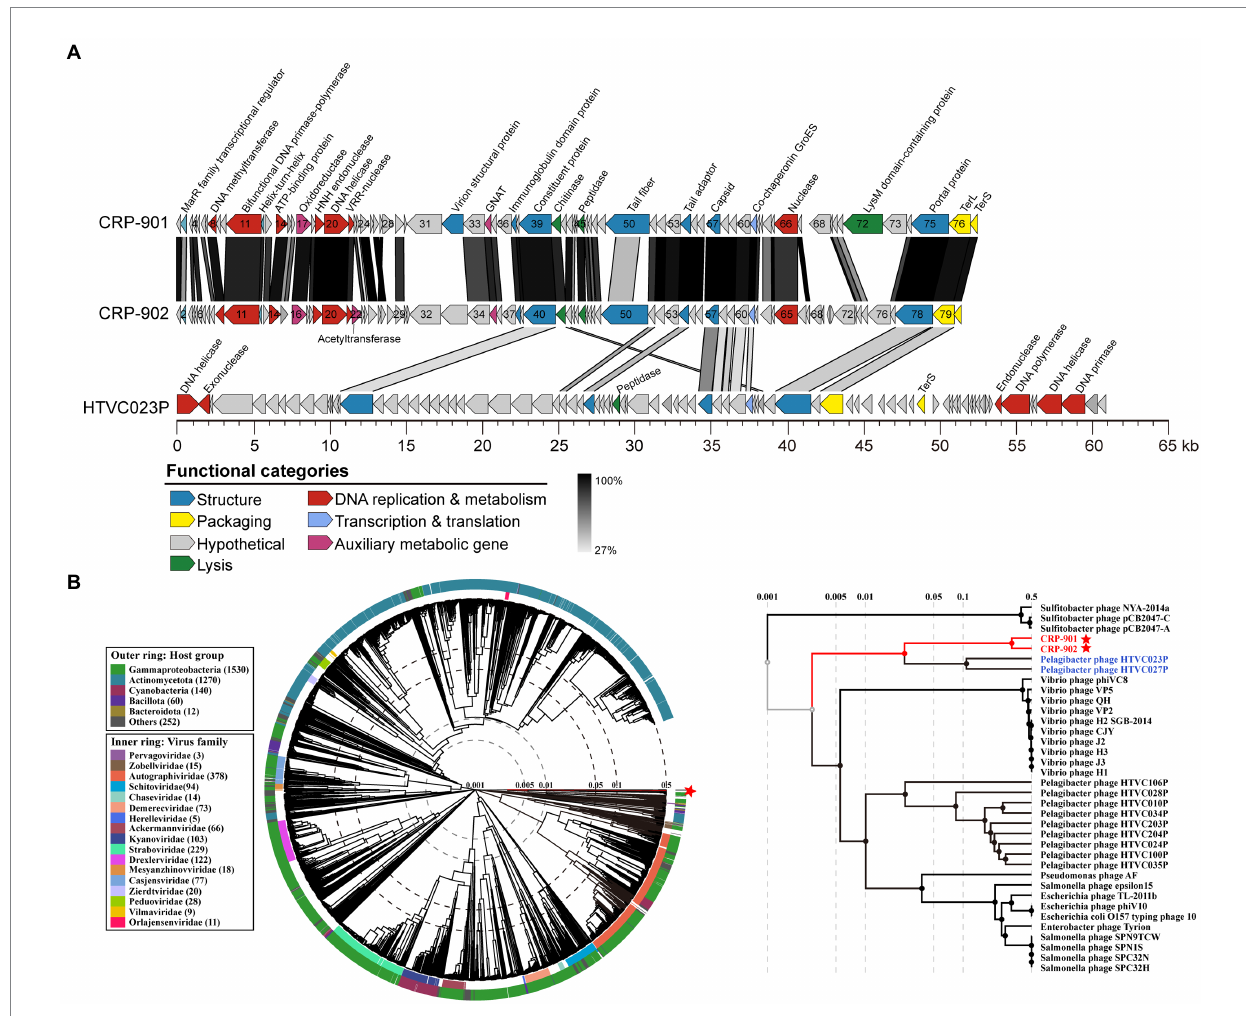
FIGURE 1 Genomic characterization and phylogenetic analysis of CRP-901 and CRP-902. (A) Genome arrangement and comparison of CRP-901, CRP-902 and pelagiphage HTVC023P. ORFs are indicated as arrows and color-coded according to their putative functions. The scale color bar indicates amino acid identities between homologous genes. (B) The genome-wide proteomic tree was constructed using VipTree for CRP-901, CRP-902, and other related known prokaryotic dsDNA phages. The colored inner and outer rings represent the virus family and host groups, respectively. CRP-901 and CRP-902 are indicated with red asterisks, and the corresponding leaves are colored red. The pelagiphage HTVC023P and HTVC027P are in blue. TerS, terminase, small subunit; TerL, terminase, large subunit; GNAT, GCN5-Related